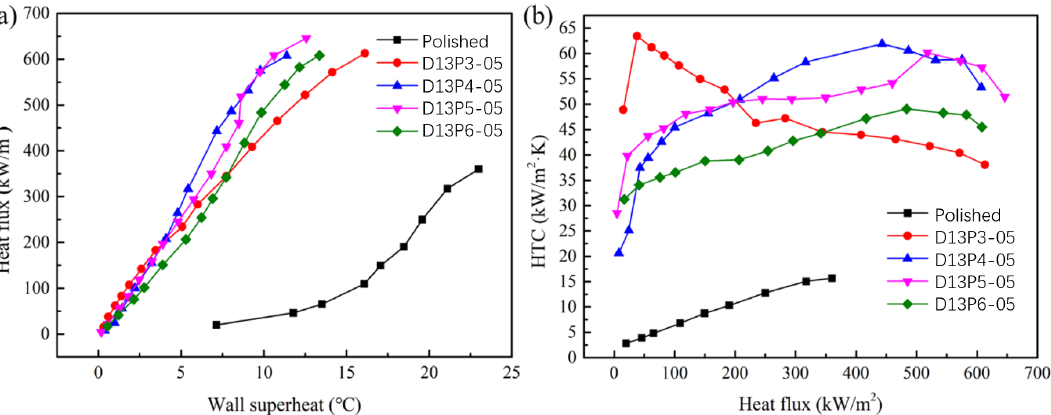
Figure 10. Sintered porous wick with different porosities (particle diameter 132 µ m): ( a ) boiling curve, ( b ) boiling heat transfer coefficient.